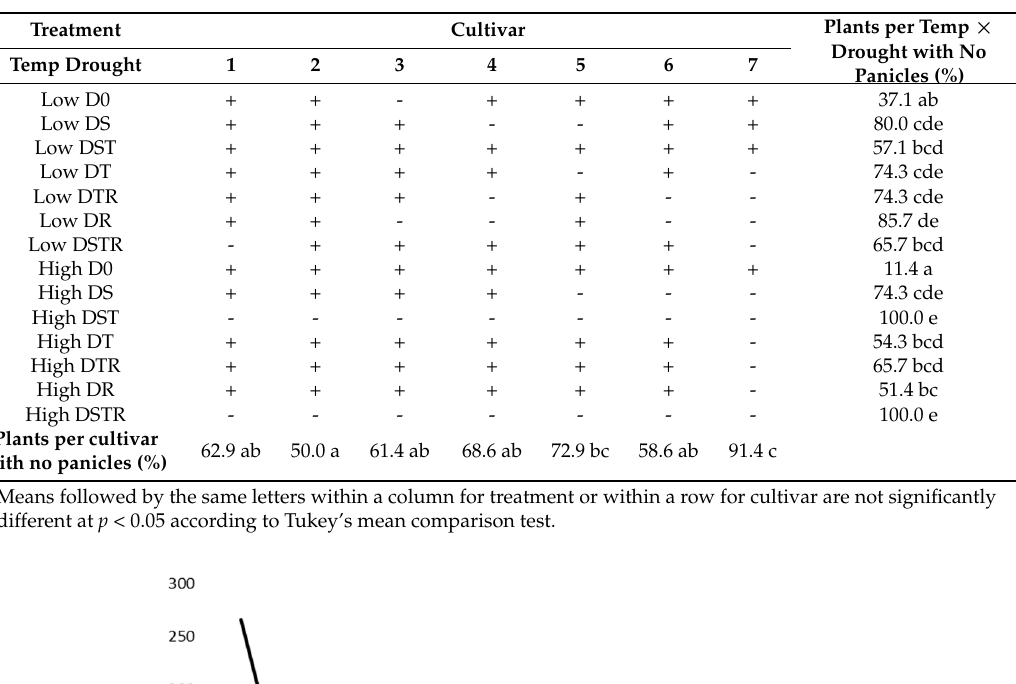
Table 4. Presence (+) and absence ( − ) of panicles plant − 1 (and thereby grain yield) and percentage of plants per rice cultivar and treatment without any panicle. Cultivars 1: Ingwizabukungu; 2: Intsindagirabigega; 3: Jyambere; 4: Mpembuke; 5 Ndamirabahinzi; 6: Nemeyubutaka; and 7: Zong geng were grown at a low or high temperature and with six different drought treatments, D0: No drought stress, DS: Drought at the seedling stage, DST: Drought at the seedling and tillering stages, DT: Drought at the tillering stage, DTR: Drought at the tillering and reproductive stages, DR: Drought at reproductive stage, DSTR: Drought at the seedling, tillering, and reproductive stages. Treatment Cultivar Plants per Temp